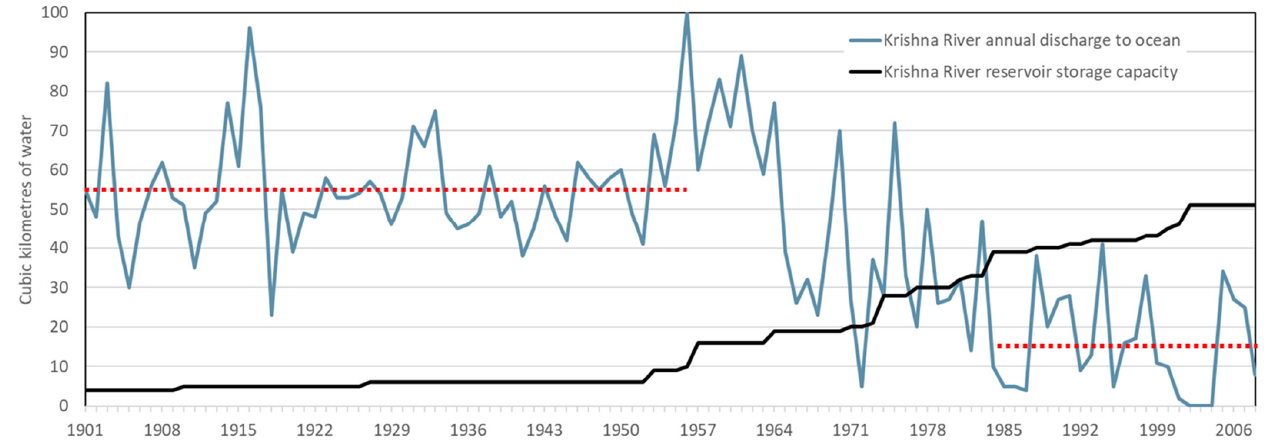
Figure 6. The Krishna River basin is reaching closure, limiting its ultimate supply to urban water users.